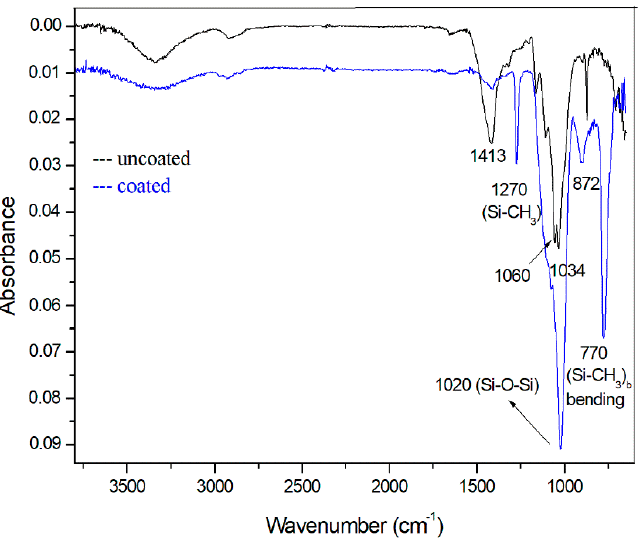
Figure 6. FTIR ATR spectra of uncoated (black line) and coated (blue line) samples of Prime Jet 80 paper.